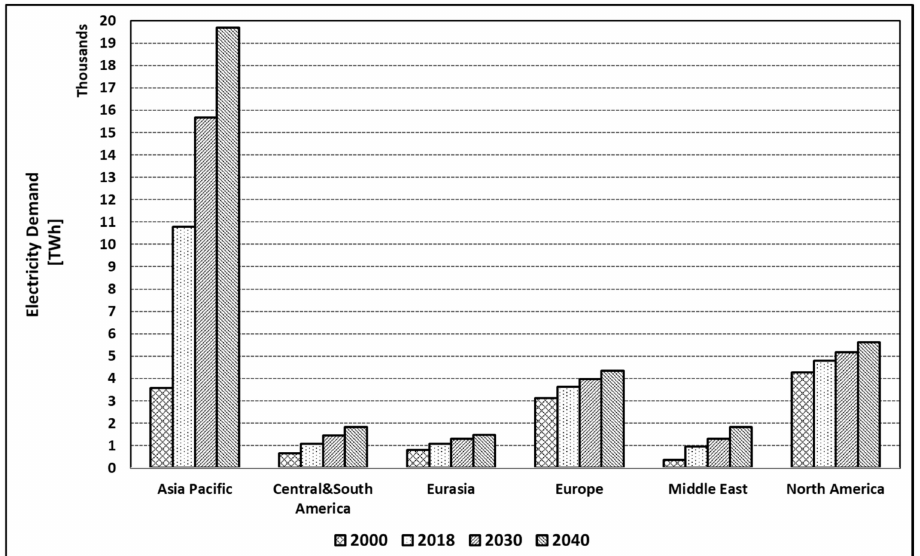
Figure 1. Projected global electricity demand between 2000 and 2040.